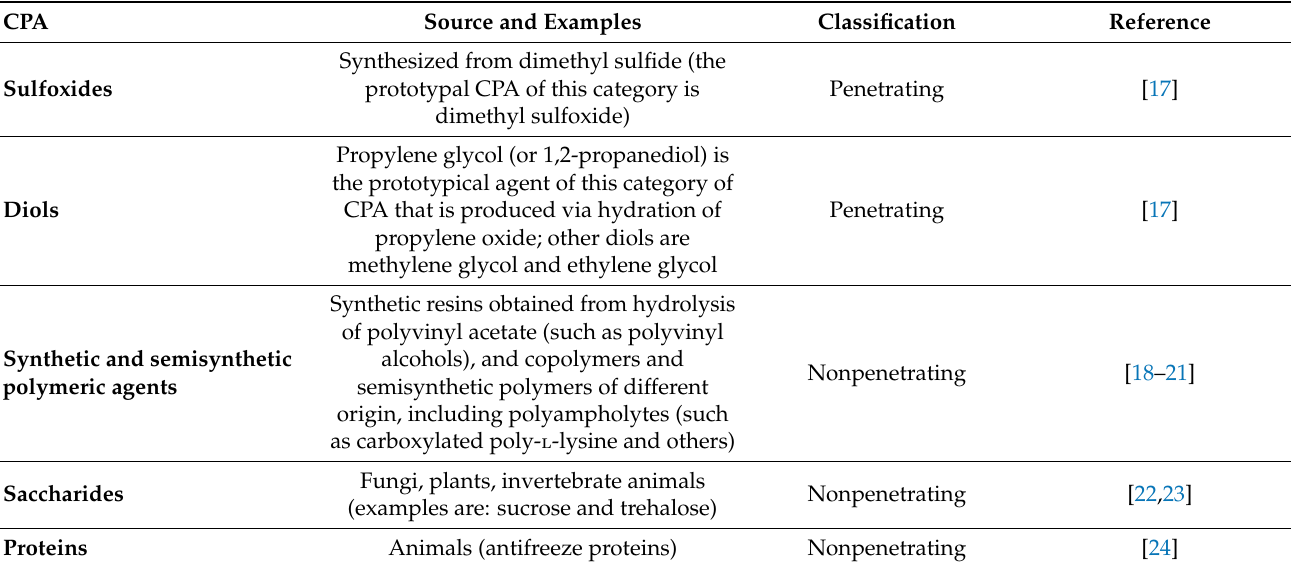
Table 1. Examples and characteristics of the most common cryoprotective agents.